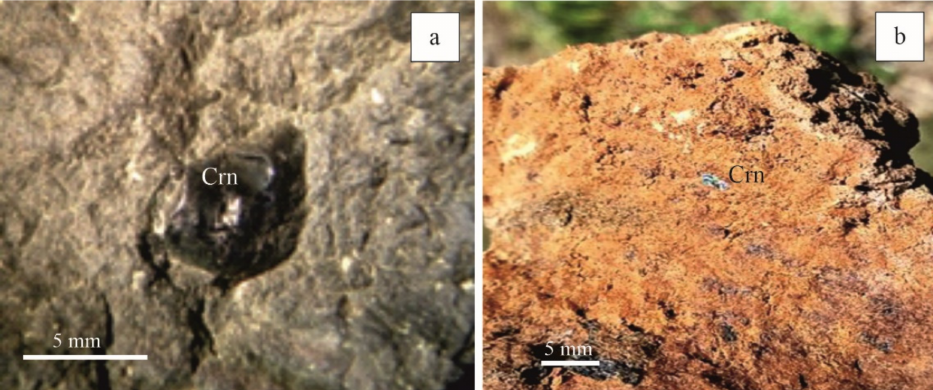
Figure 4. Sapphire grains. ( a ) Sapphire grain in basalt, Darkhintuy River vicinity. A.V. Tatari- nov’s photo. ( b ) Blue sapphire crystal in weathered tuff Naryn-Gol River, near Root Trench. O.Yu. Korshunov’s photo. Crn: corundum. 3.2. Corundum The Naryn-Gol corundum is blue, light blue, green, yellow, gray, brown, and even dirty pink, though rare (Figure 5). The stones are mostly blue and light blue, often with zonal and spotty coloration.